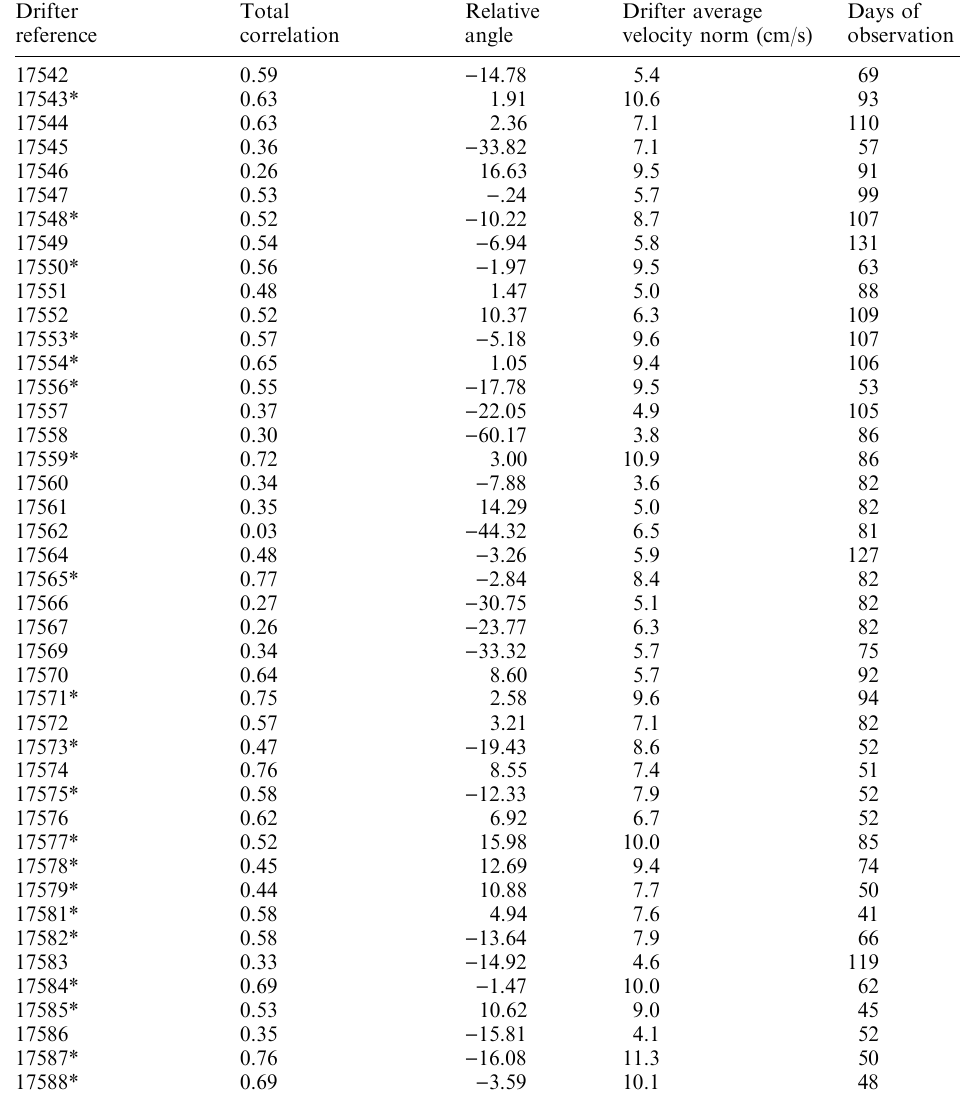
Drifter reference